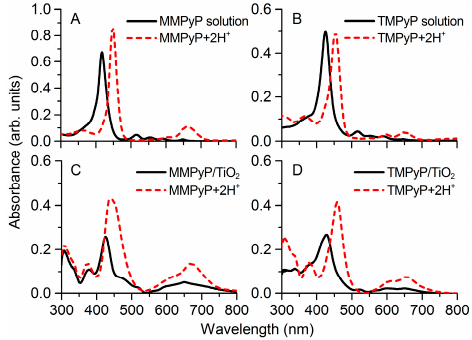
Figure 2. Absorbance spectra of ( A , C ) MMPyP and ( B , D ) TMPyP in ethanol solution and in TiO 2 solid films before (solid black line) and after protonation (dashed red line).